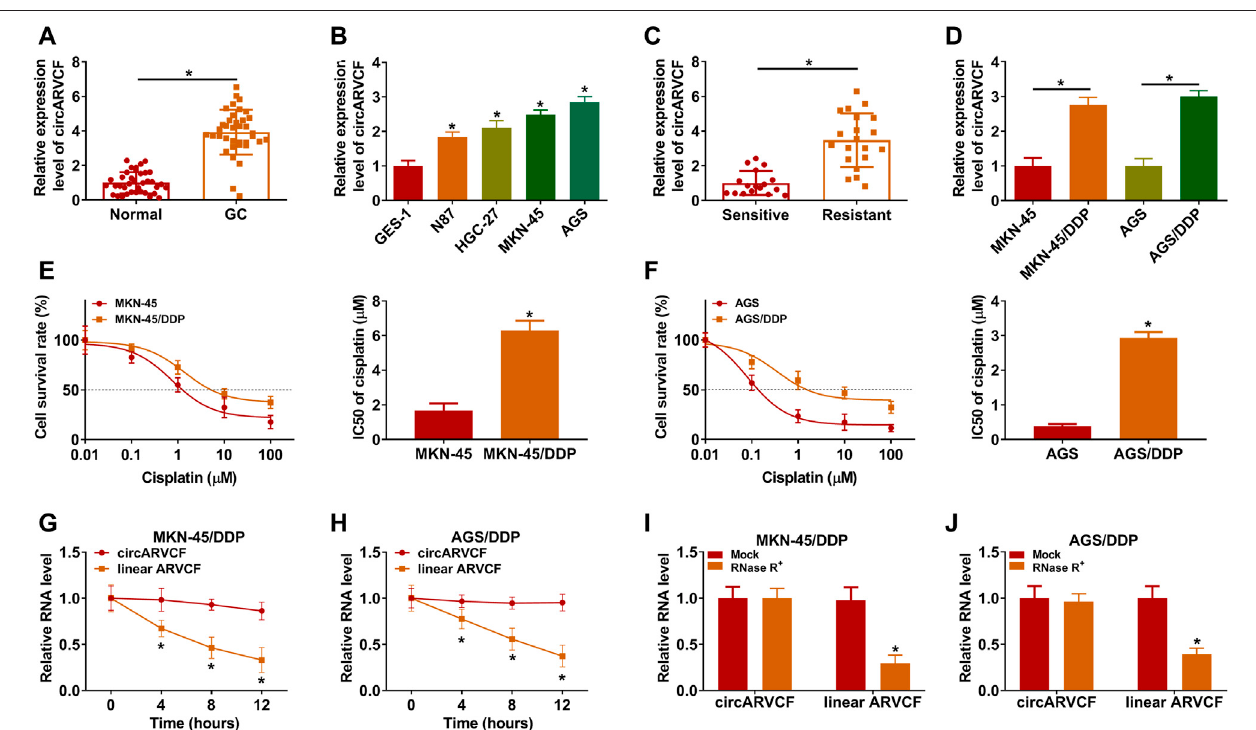
FIGURE 1 | CircARVCF was overexpressed in DDP-resistant GC tissues and cells. (A) CircARVCF expression in GC tissues and normal tissues was detected via qRT-PCR. (B) CircARVCF expression in GES-1, N87, HGC-27, MKN-45, and AGS cells was detected by qRT-PCR. (C) CircARVCF expression in DDP-resistant GC tissues and DDP-sensitive GC tissues was detected by qRT-PCR. (D) CircARVCF expression in MKN-45, MKN-45/DDP, AGS, and AGS/DDP cells was detected by qRT-PCR. (E,F) IC50 ofcisplatin in MKN-45, MKN-45/DDP,AGS, and AGS/DDP cells was assessed byCCK-8 assay. (G,H) The levels ofcircARVCF and ARVCF in MKN-45/DDP and AGS/DDP cells treated with Actinomycin D were examined by qRT-PCR. (I,J) Total RNA in MKN-45/DDP and AGS/DDP cells was treated with RNase R and then circARVCF and linear ARVCF levels were detected by qRT-PCR. * p <